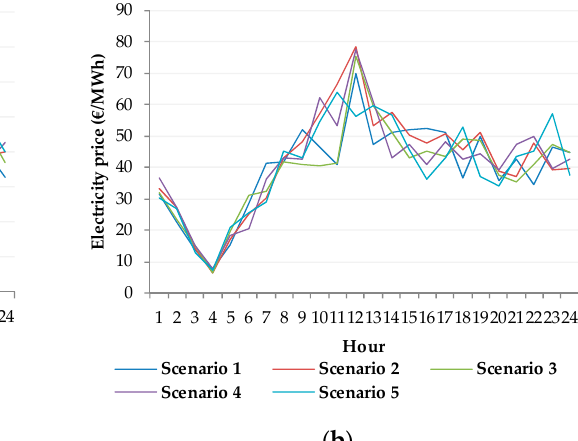
( d ) Figure A4. PV power output scenarios of Cases 2–5 randomly generated: ( a ) 100 scenarios (Case 2); ( b ) 150 scenarios (Case 3); ( c ) 200 scenarios (Case 4); ( d ) 250 scenarios (Case 5). References 1.